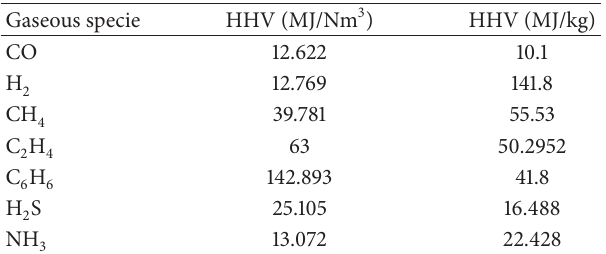
Table 2: High heating values of the gaseous species considered in the syngas leaving from the gasifier